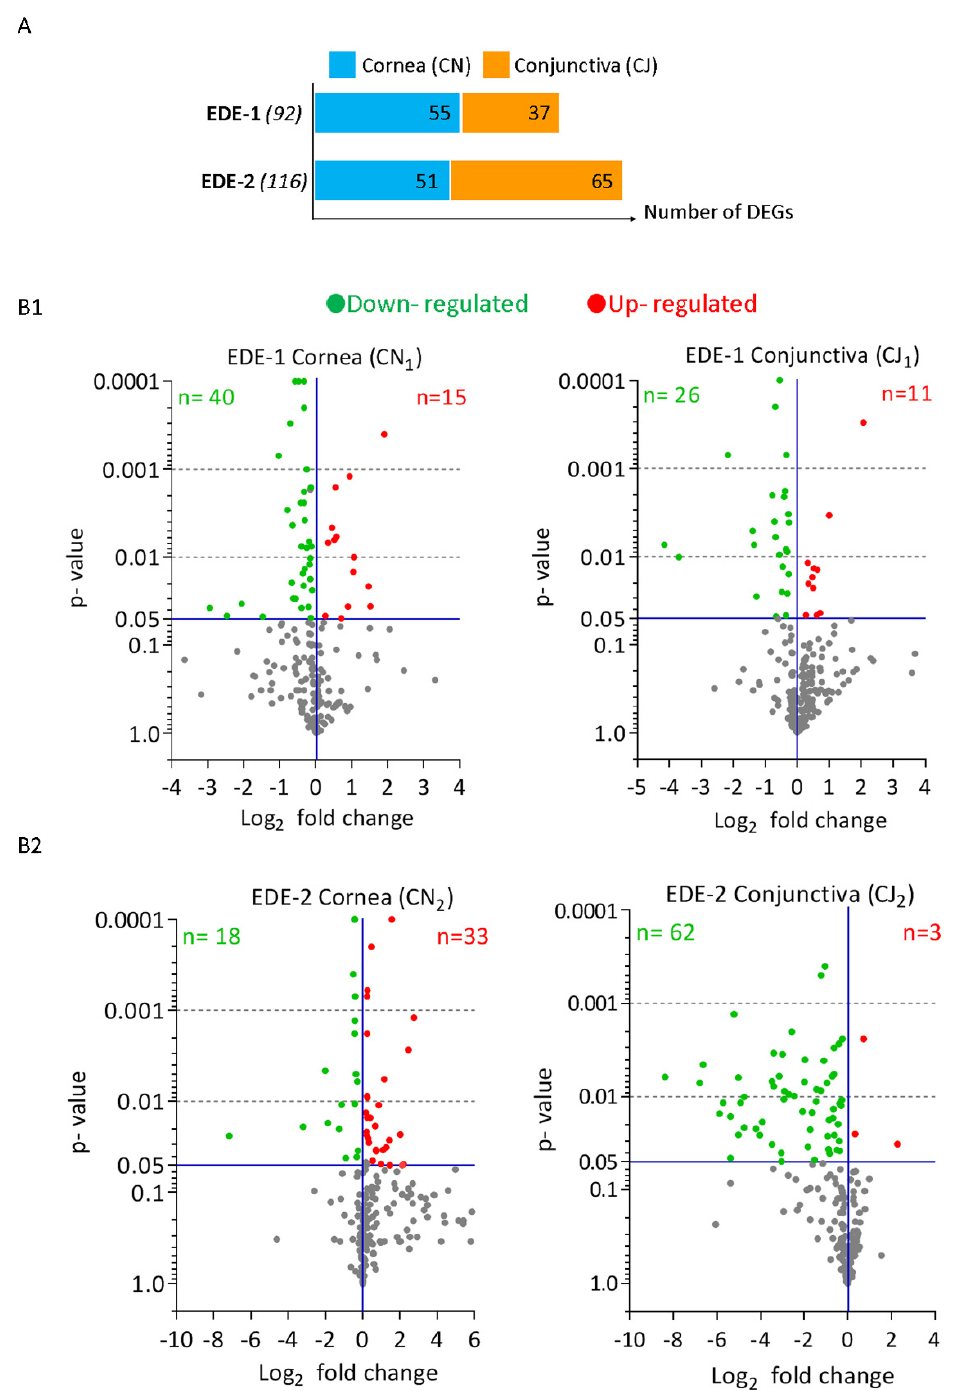
Figure 2. Differentially expressed genes (DEGs) in cornea and conjunctiva of both EDE mouse models: ( A ) Number and distribution of DEG in cornea and conjunctiva. ( B ) Volcano plot of DEGs between healthy controls and EDE-1 ( B1 ) and EDE-2 ( B2 ) depending on the tissue. X -axis and y -axis represent log 2 fold-change difference between experimental model against healthy controls, respectively, and statistical significance as the p -value. Significantly up-regulated and down-regulated genes are indicated with red and green dots, while non-significant genes are shown as gray dots. The number of DEGs is indicated between brackets. ( B1 ) DEGs distribution of EDE-1 in cornea (CN 1 ) and conjunctiva (CJ 1 ). ( B2 ) DEGs distribution in EDE-2 in cornea (CN 2 ) and conjunctiva (CJ 2 ). CN, cornea; CJ,